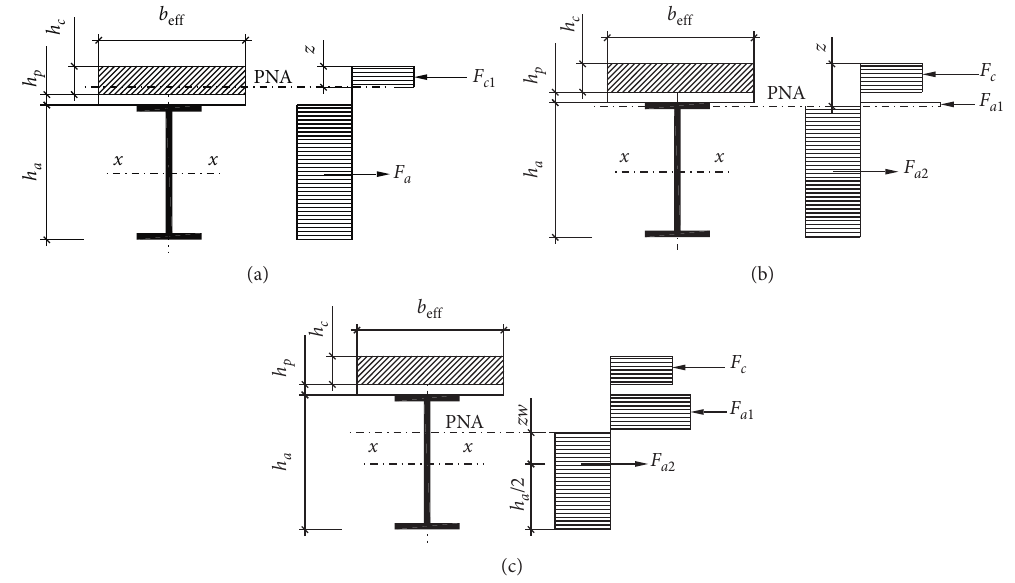
Figure 3: Plastic design of the steel-reinforced concrete beams: (a) when PNA lies in concrete slab; (b) when PNA lies in steel flange; and (c) when PNA lies in steel